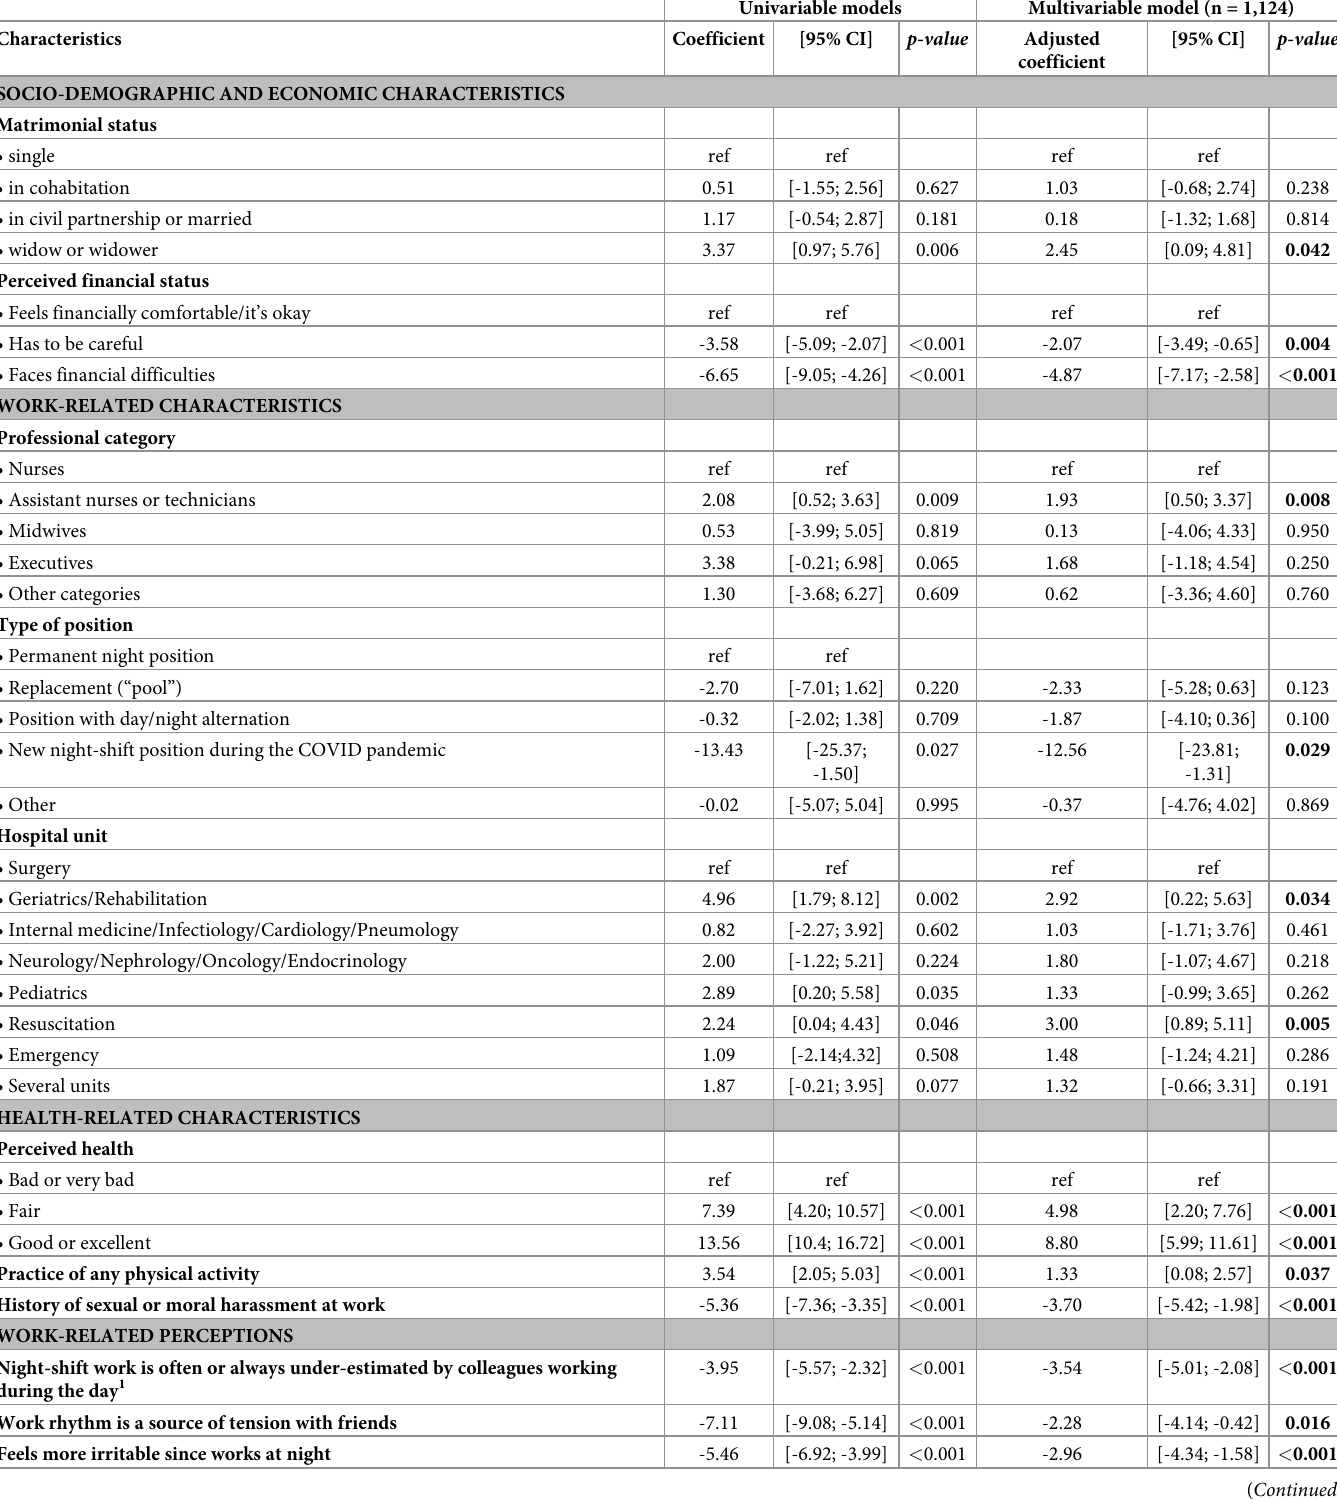
Table 3. Factors associated with quality of working life among night-shift healthcare workers: Linear regression models with full-scale WRQoL score as the outcome (n = 1,387, ALADDIN survey, Paris public